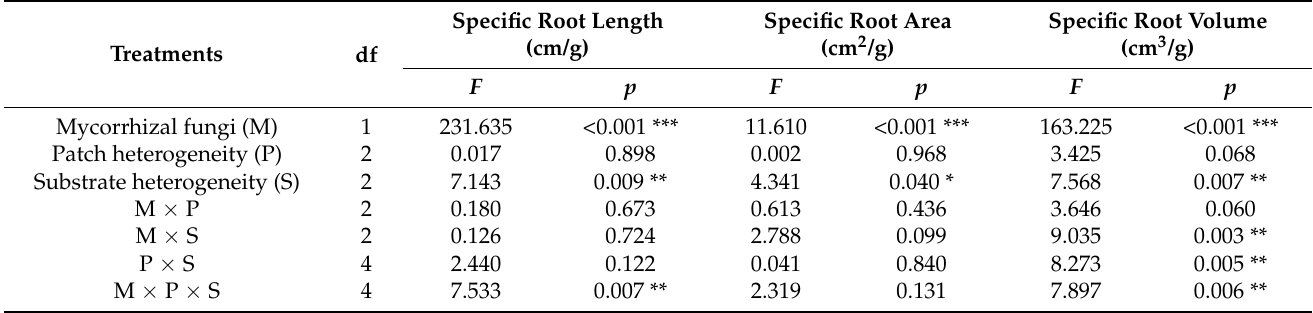
Table 5. Three-way ANOVA for the effect of mycorrhizal fungus (M + vs. M − ), patch heterogeneity (Homo vs. Hetl vs. Hets), and soil substrate heterogeneity (GL vs. GF vs. GH) on specific root traits.